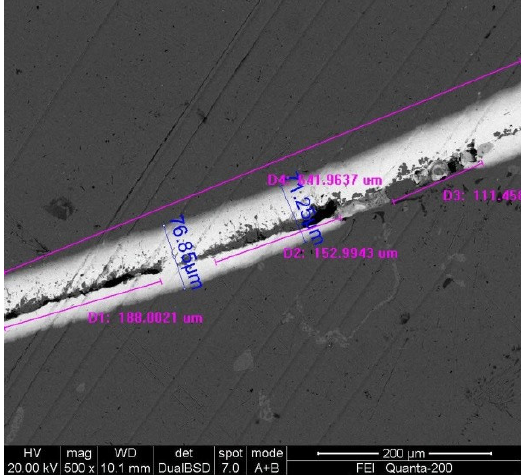
Figure 13. Cross-sectional SEM morphologies of micro defects for the sample brazed at 535 ◦ C.